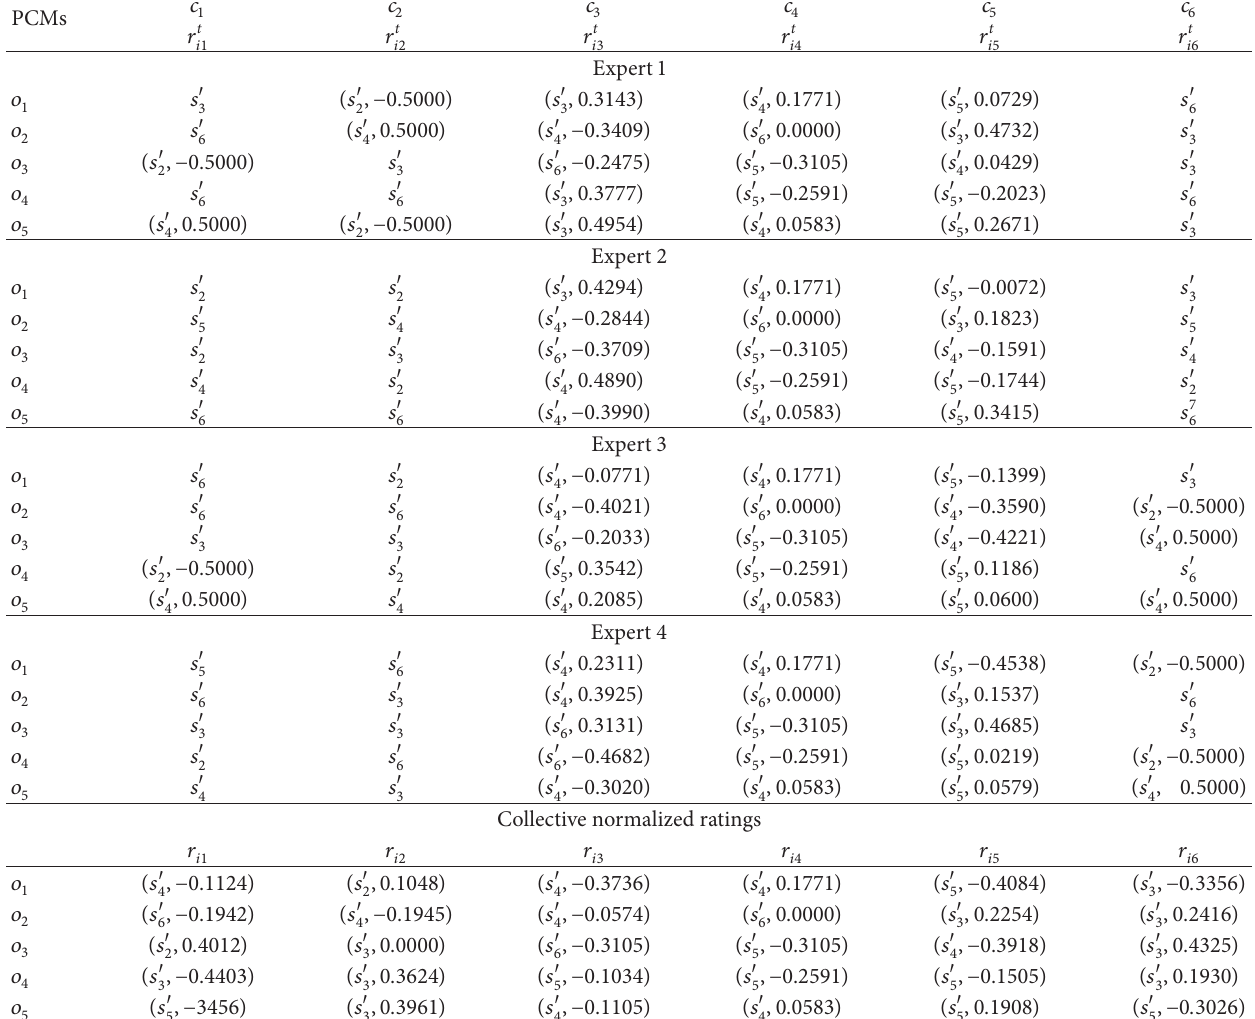
Table 3: Individual and corrective normalized ratings.